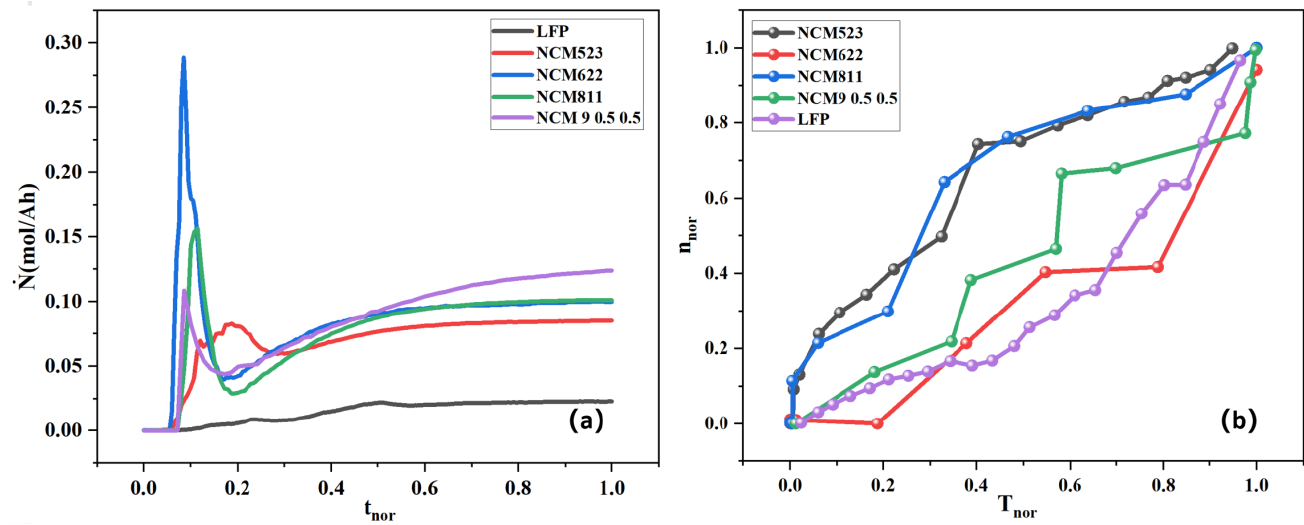
Figure 8. ( a ) (Gas production/gas production time) normalization and ( b ) (gas production/battery temperature) normalization.